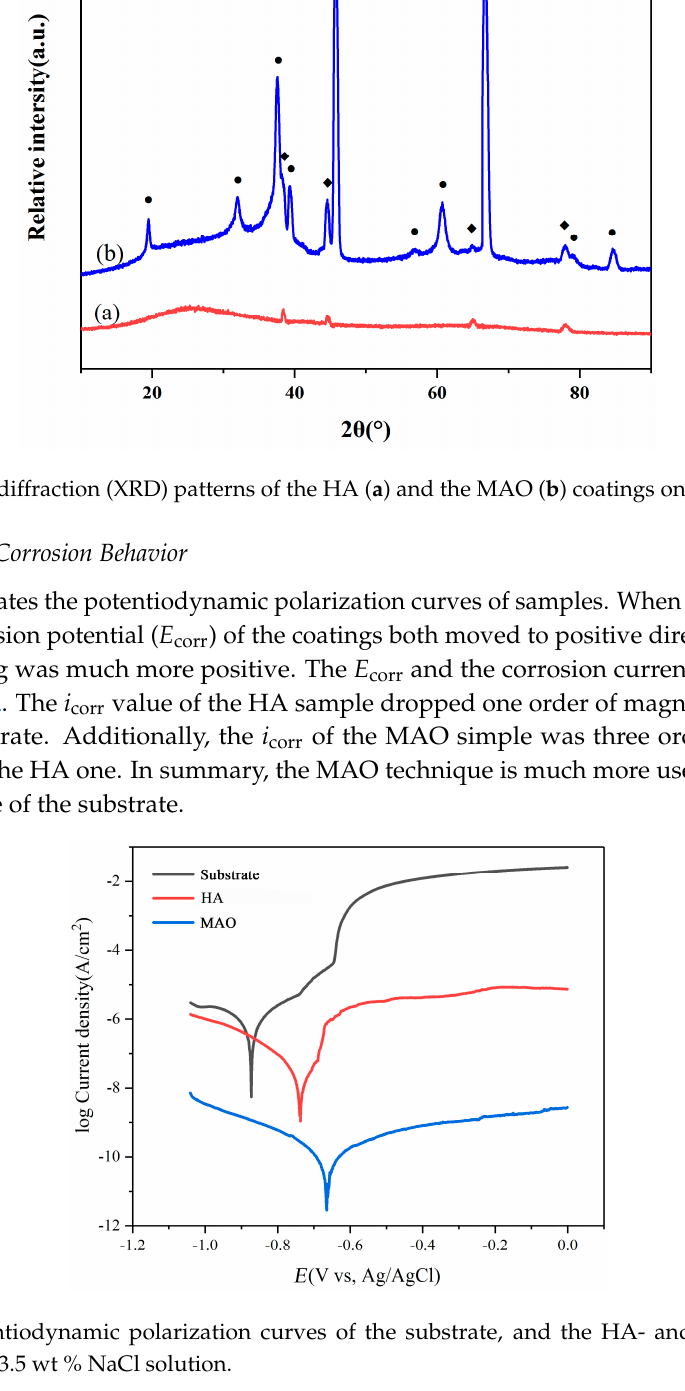
Table 2. Fitting results of potentiodynamic polarization Figure 5. Potentiodynamic polarization curves of the substrate, and the HA- and MAO-treated 7050 Al alloy in 3.5 wt % NaCl solution.